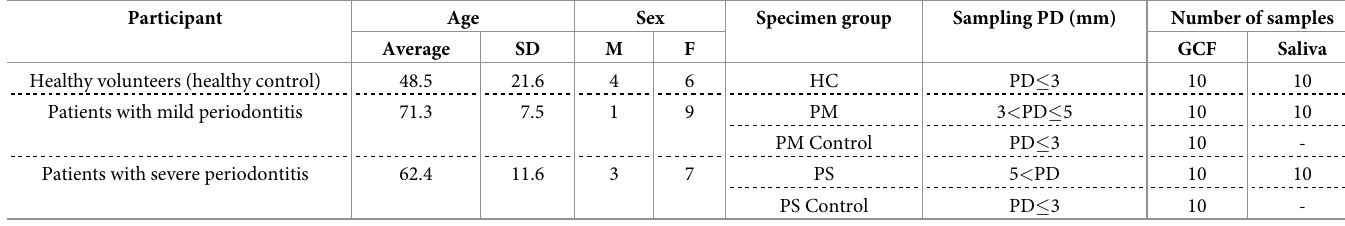
Table 1. Background data of healthy controls and periodontitis